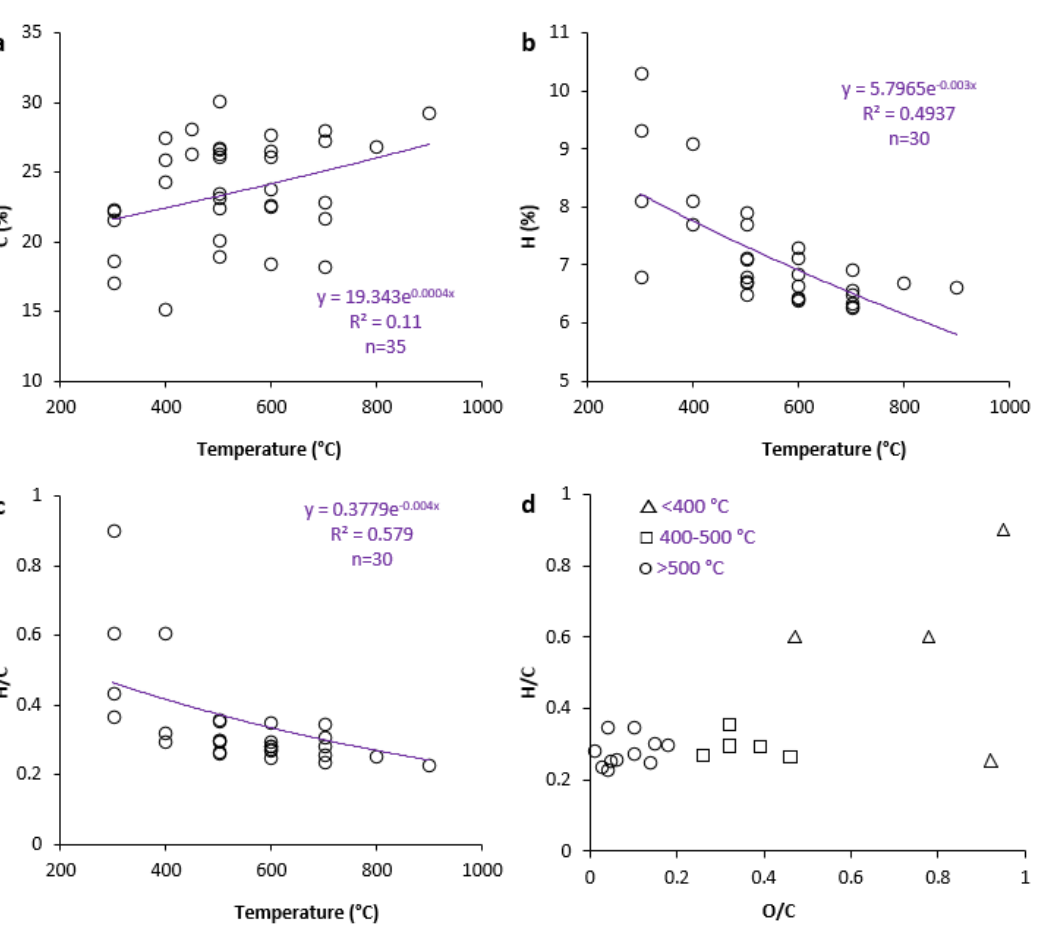
Figure 3. Relationship between traits for sewage sludge biochars and their pyrolysis temperature and Van Krevelen diagram for rice husk biochars produced at different pyrolysis temperatures. ( a ) C % vs. Temperature; ( b ) H % vs. Temperature; ( c ) H/C % vs. Temperature; ( d ) H/C % vs. O/C.